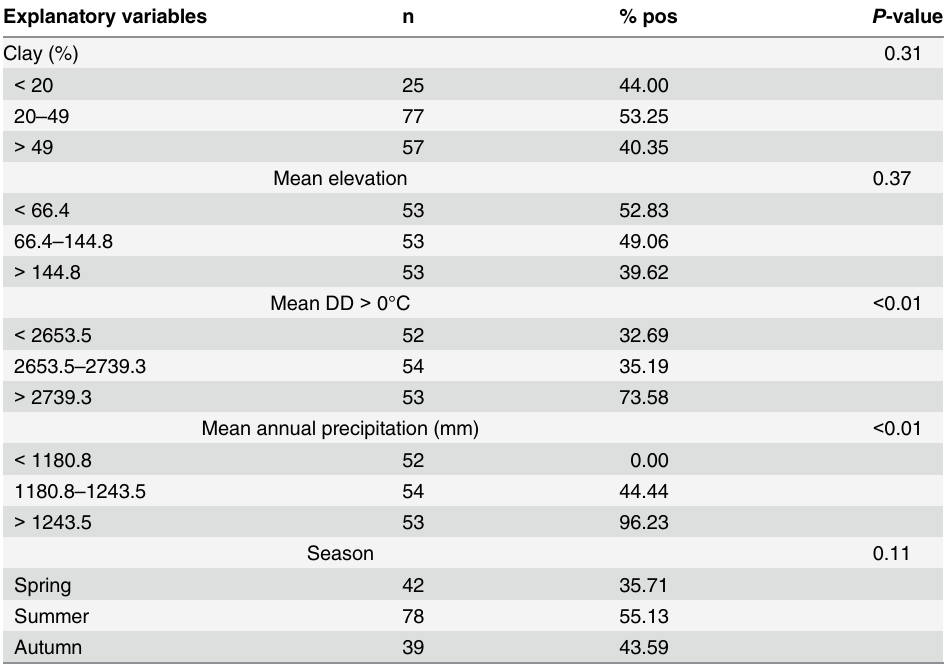
Table 5. Results of univariate analyses for predicting whether H . leporispalustris -positive sites were inside or outside the spatial cluster. Explanatory